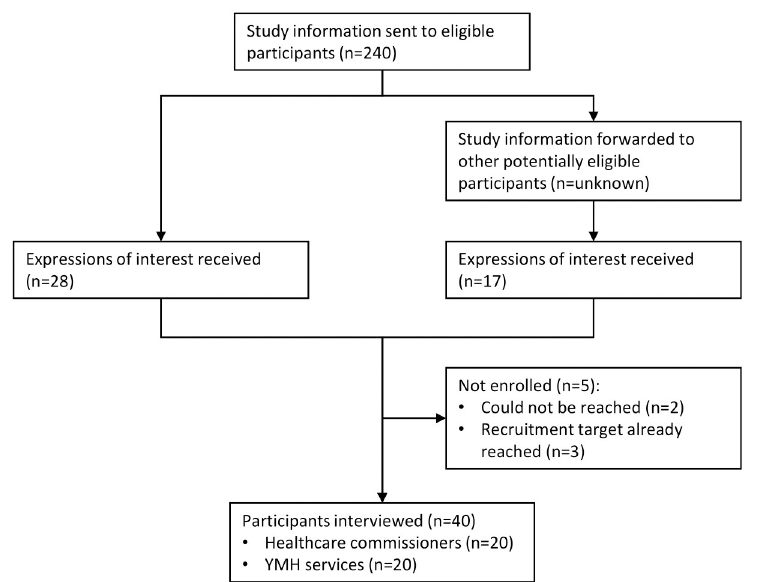
Fig 1. Flow chart of participants’ recruitment to the